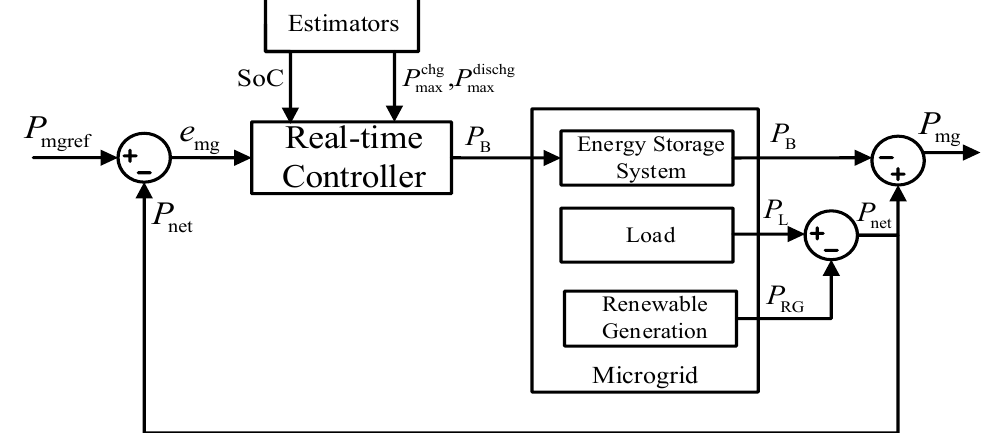
Figure 2. Block diagram at the microgrid level. SoC: state of